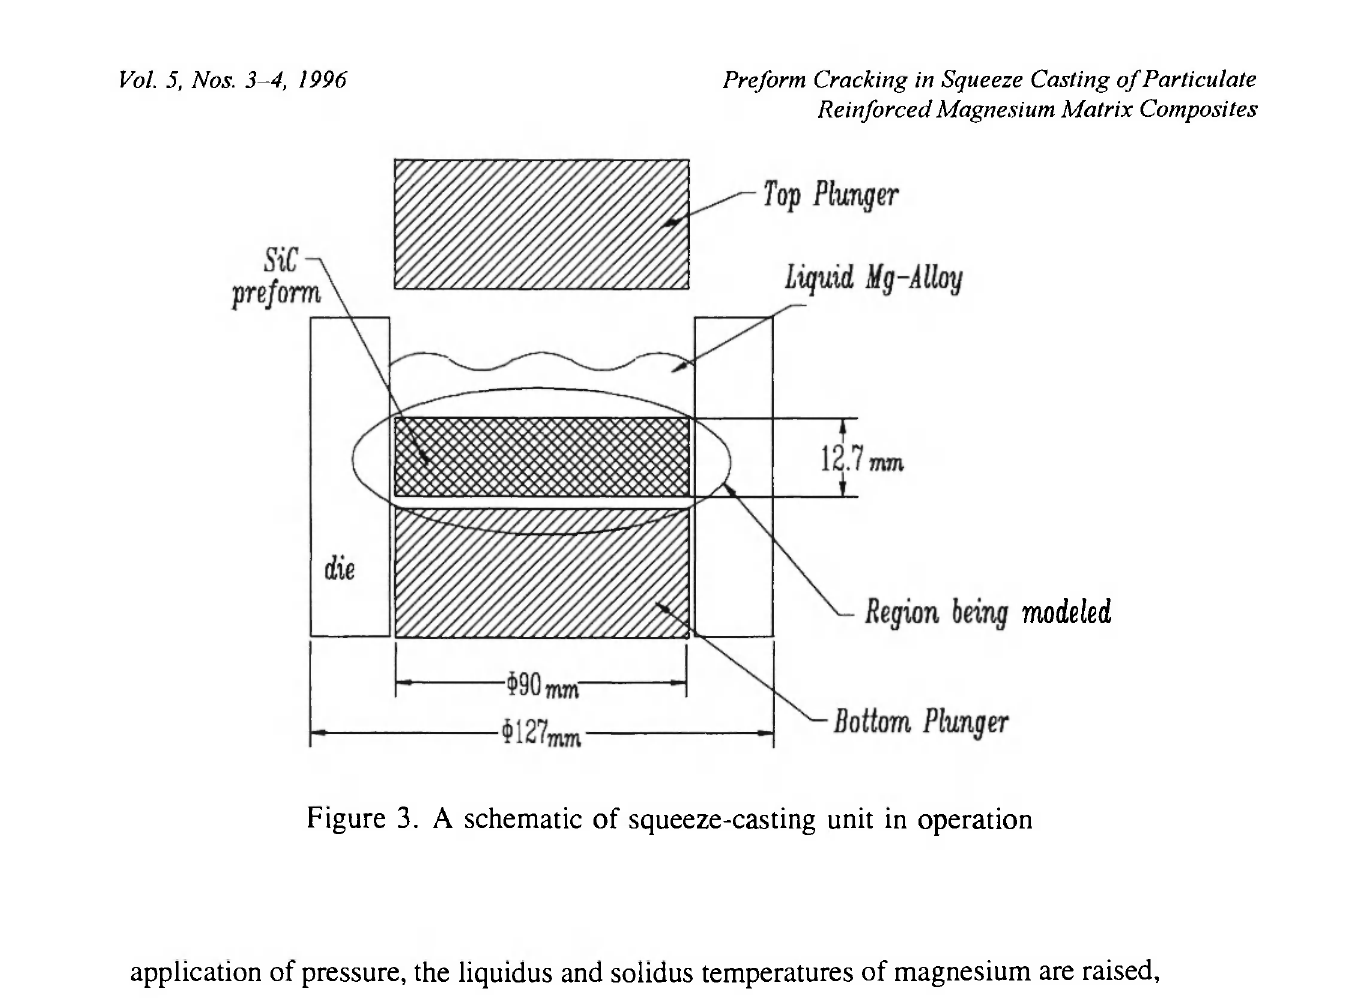
Figure 3. A schematic of squeeze-casting unit in